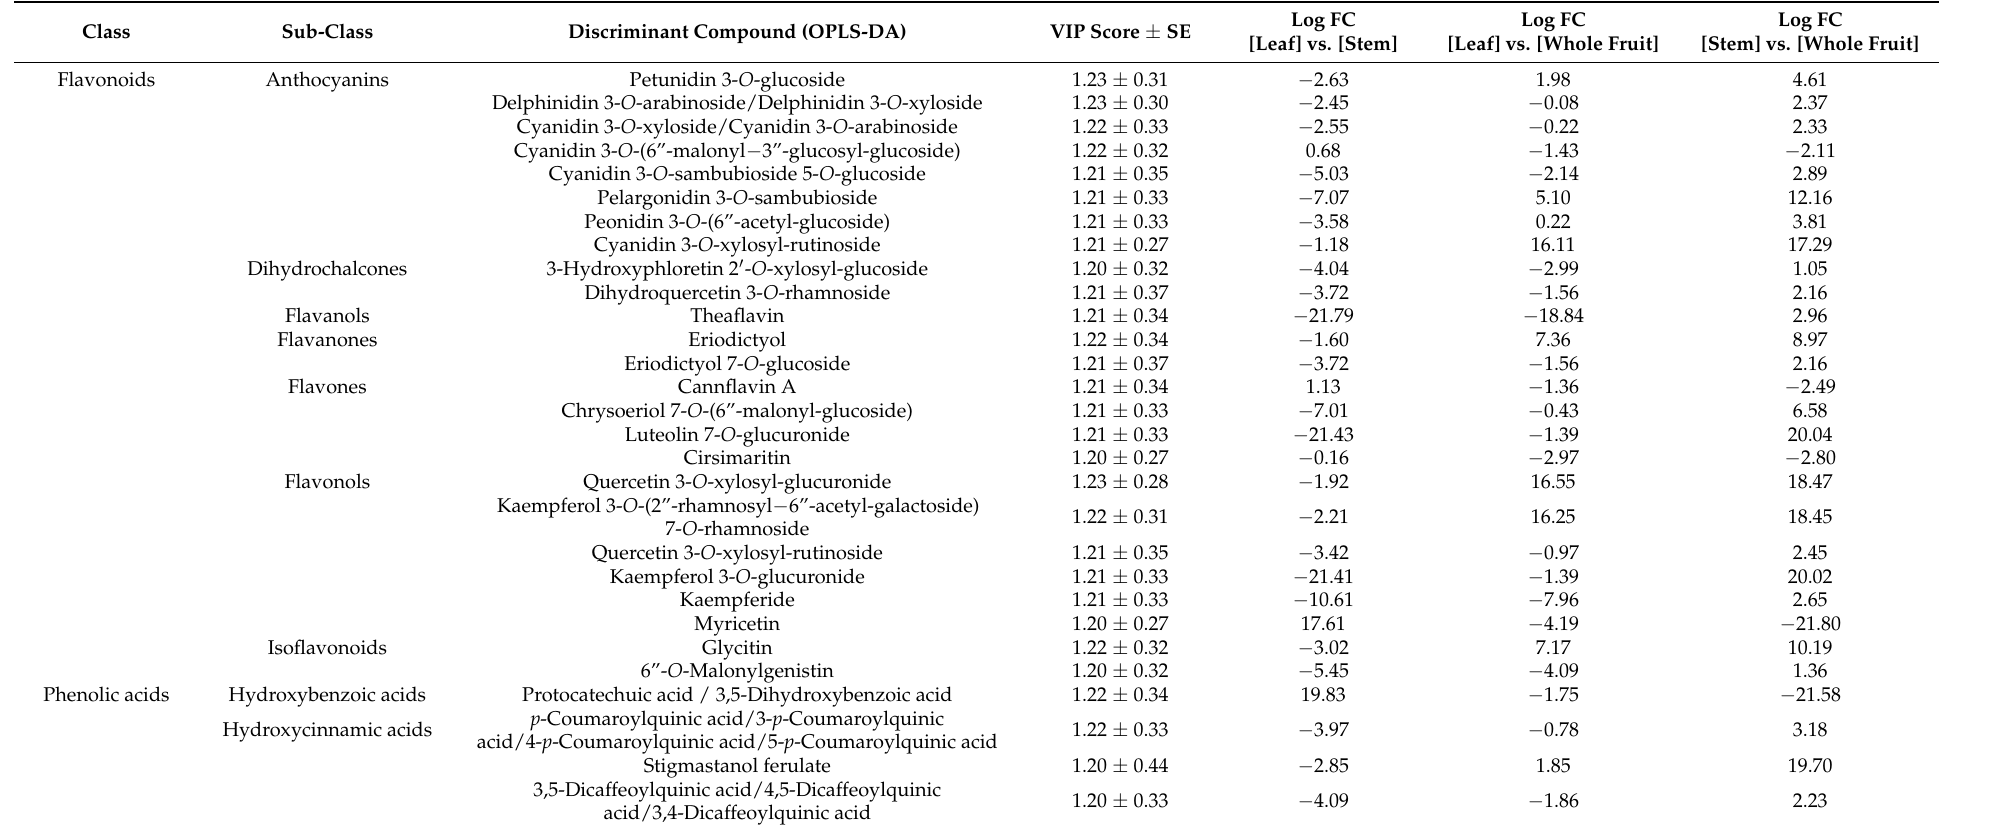
Table 1. Discriminant polyphenol compounds identified by the VIP (variable importance in projection) with a score > 1.2. VIP makers were classified in classes and subclasses according to the Phenol Explorer database. Each compound as provided with a VIP score ± standard error and log fold-change values obtained by pairwise comparison among different Cydonia oblonga Mill.